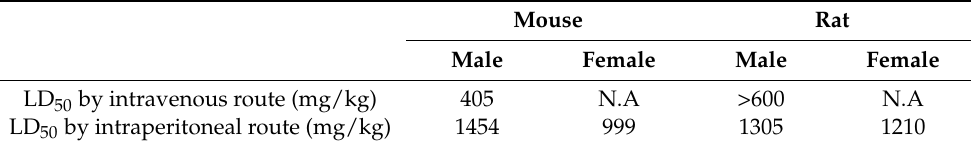
Table 5. LD/LC 50 values relevant classification (“N.A”: No data applicable or available).